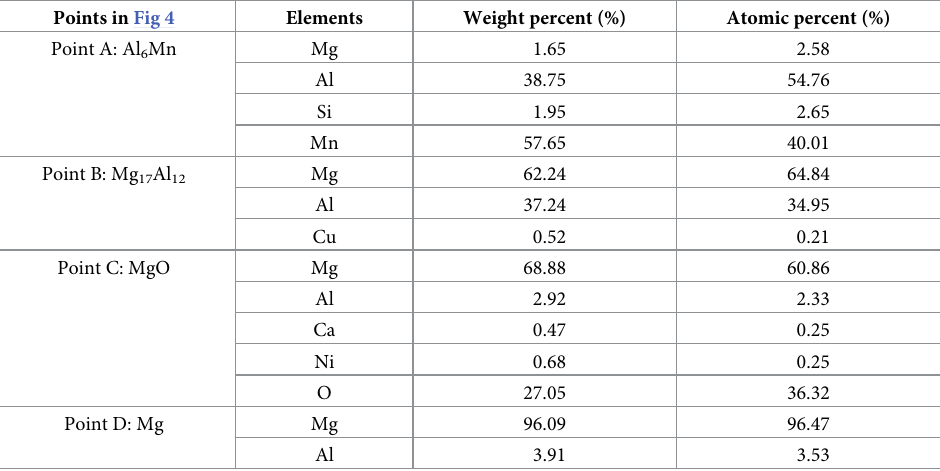
Table 1. The EDS result in Fig 4 for the elemental analysis in the AM60 magnesium